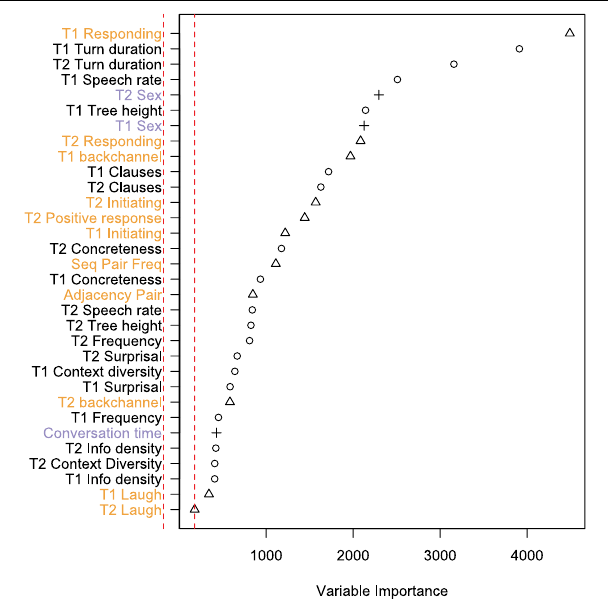
FIGURE 4 | Variable importance in a random forest analysis of floor transfer offset. The dotted red line shows the absolute smallest value, which can be used as a baseline for spurious effects. Measures of processing appear as circles (black labels) and measures of sequence organization appear as triangles (orange labels). Other measures appear as crosses (purple